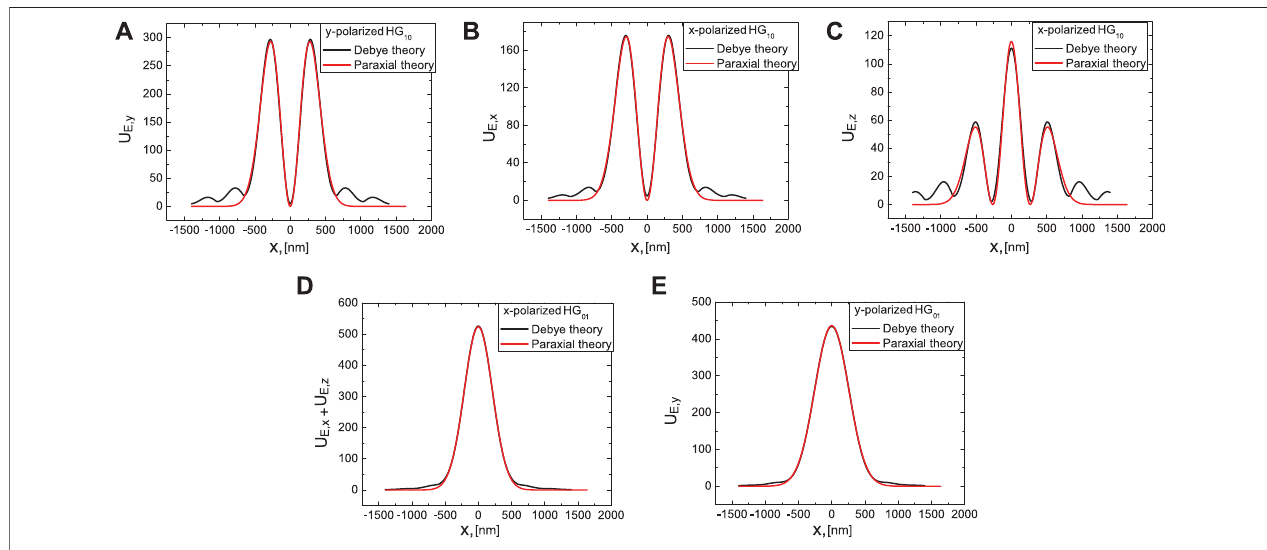
FIGURE 3 | Comparison of calculated components of the projections of electric fi eld energy densities between an approximation (paraxial theory, red) and exactly calculated projections using Richards-Wolf integrals (vectorial diffraction theory (Debye), black). The wavelength is λ (cid:1) 700nm, the numerical aperture ( NA ) is 0.9, the focal length is f (cid:1) 2 . 0mm and the beam width of HG modes at the entrance pupil is w 0 (cid:1) 1 . 74mm. Indices for Hermite-Gaussian modes are shown in the